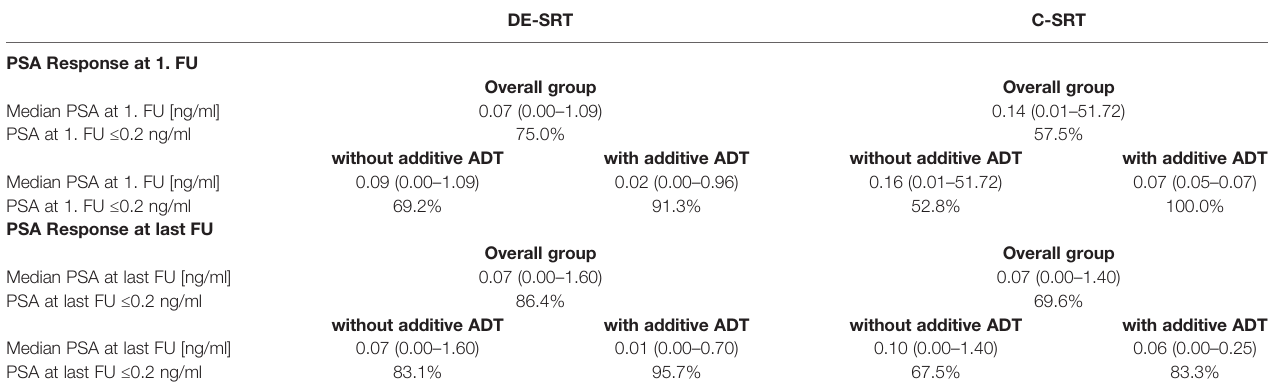
TABLE 6 | Outcome of dose-escalated (DE-SRT) and conventional (C-SRT) salvage radiotherapy. DE-SRT C-SRT PSA Response at 1. FU